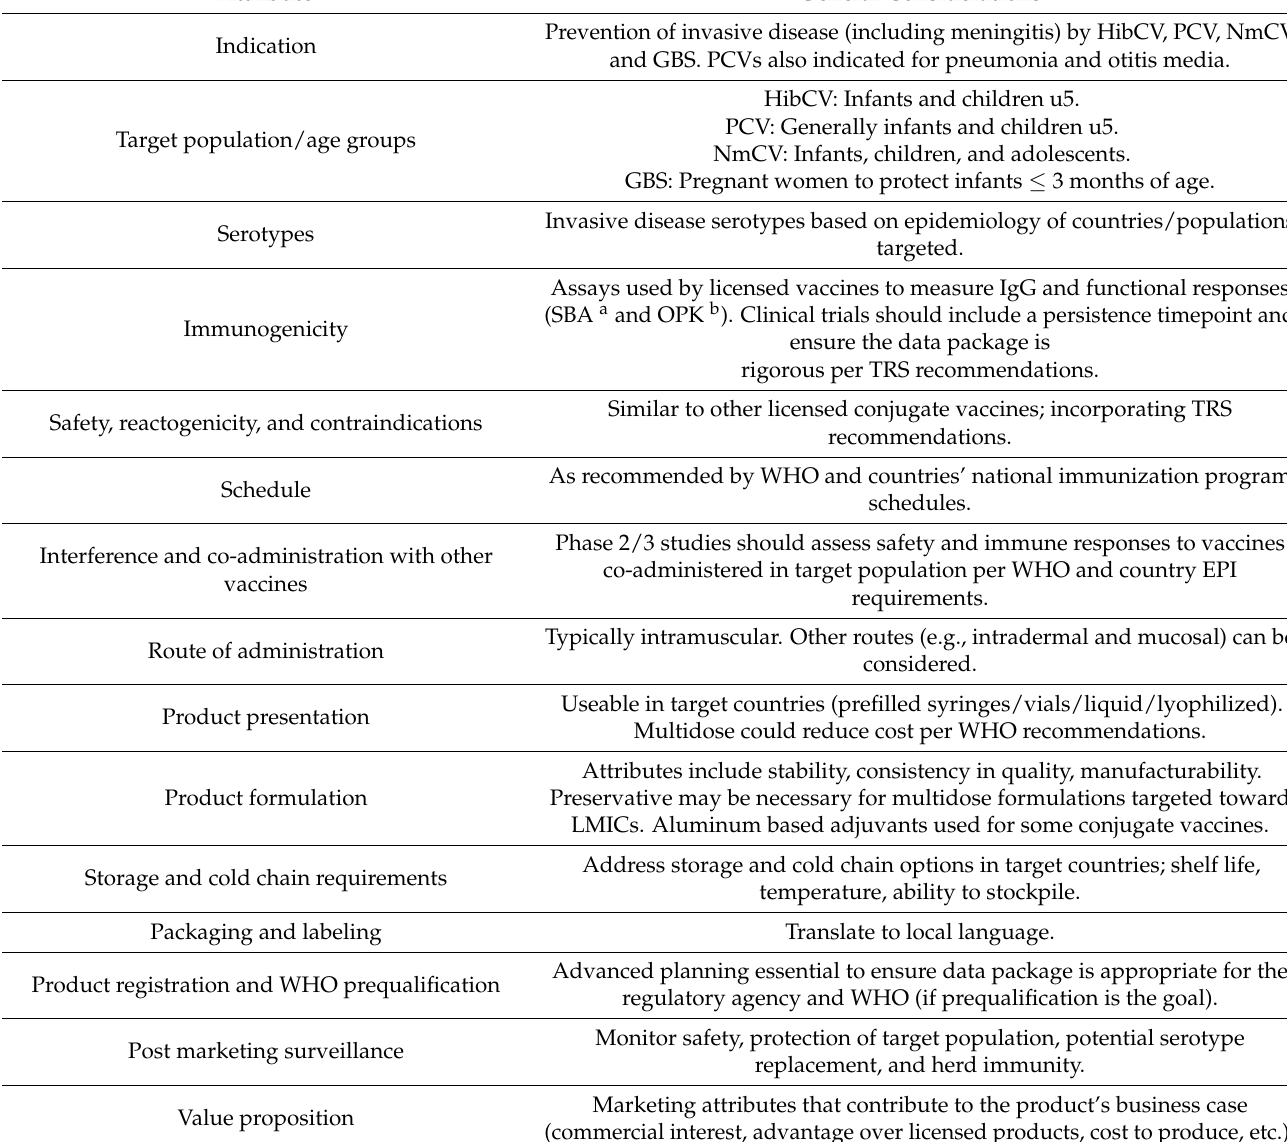
Table 2. Components of a meningitis vaccine Target Product Profile